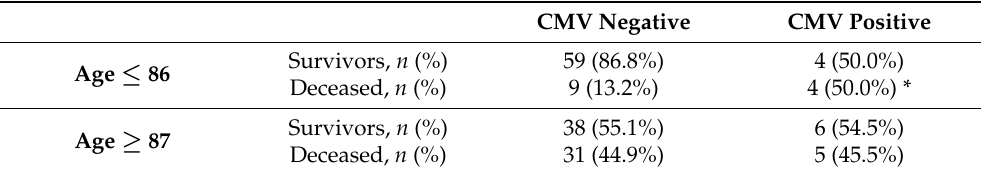
Table 2. Frequency distribution of CMV positive patients in relation to in-hospital death after age-stratification.